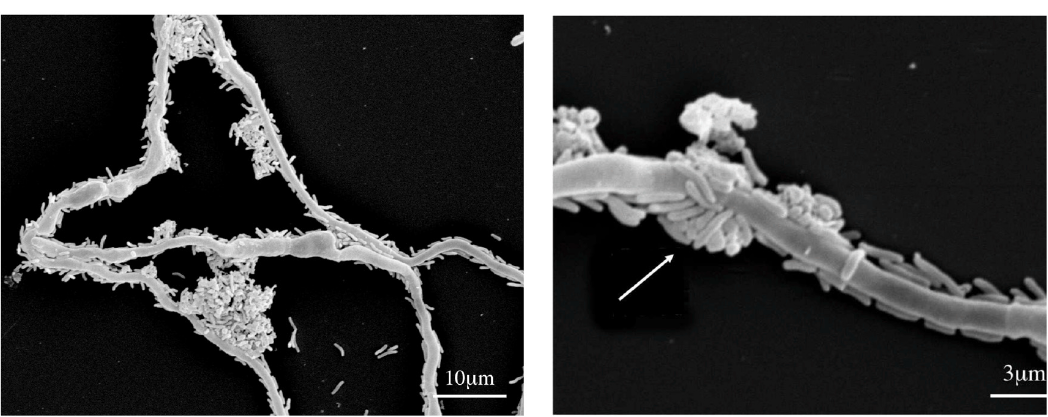
Figure 1. Scanning electron microscopy of colonization of Fusarium oxysporum f. sp. radicis-lycopersici (Forl) hyphae by cells of Pseudomonas fluorescens WCS365 after incubation for 72 hours in tomato root exudate. The right photo is a detail from the left photo but with a higher magnification (the arrow indicates a bacterial microcolony). Reproduced from Kamilova et al. 23 by permission of the